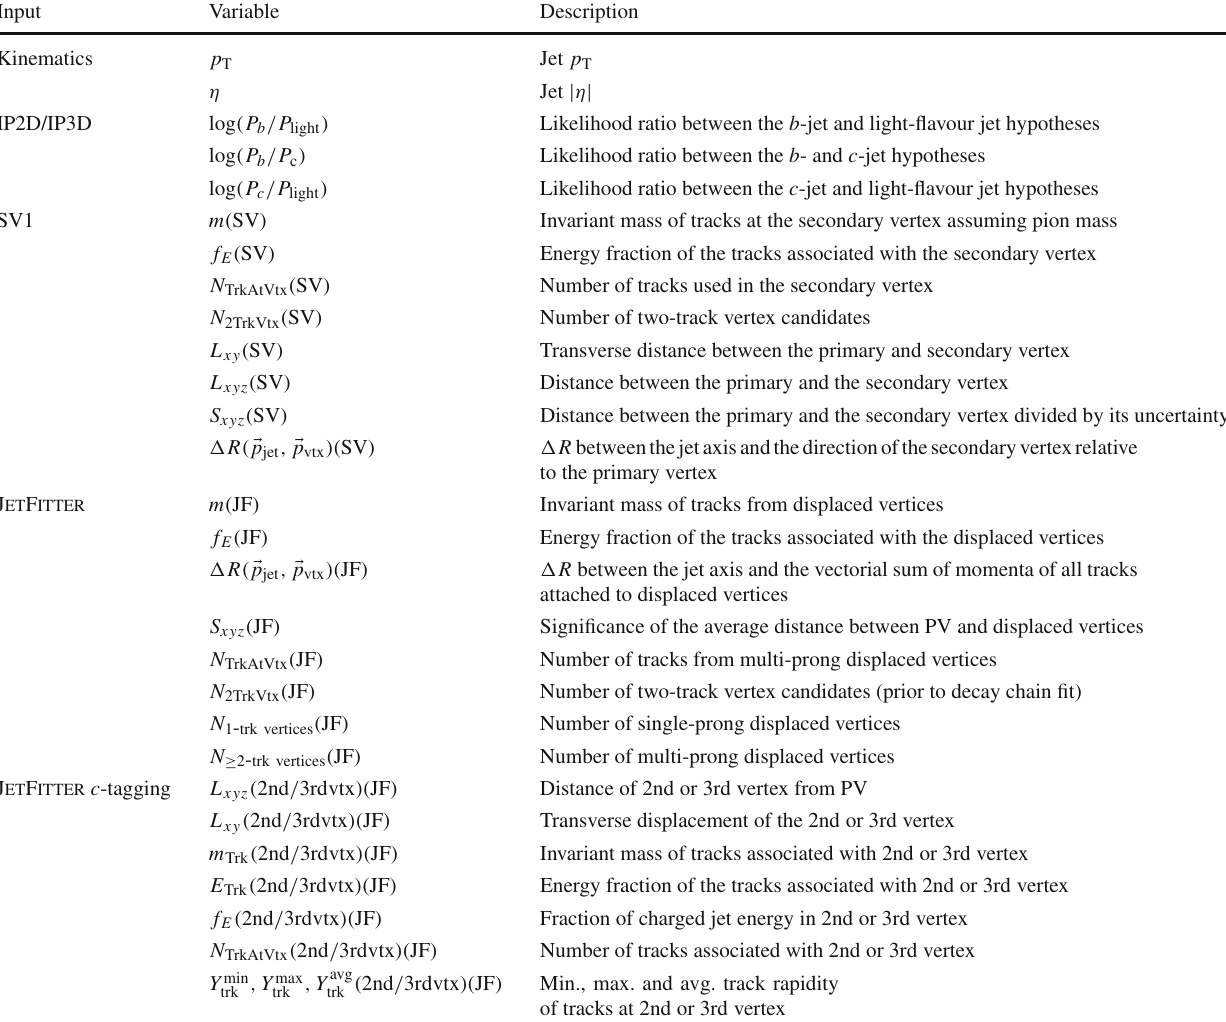
Table 1 Input variables used by the MV2 and the DL1 algorithms. The JetFitter c -tagging variables are only used by the DL1 algorithm